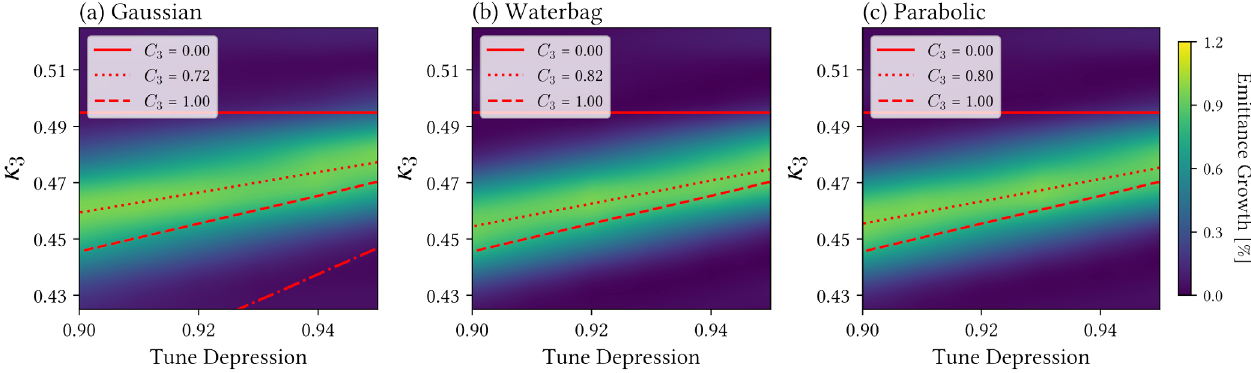
FIG. 16. Emittance growth chart of the sum resonance with ð k; l Þ ¼ ð 2 ; 1 Þ excited by the sextupole driving perturbation. The perturbation amplitude is set at 0.4% of the focusing field ’ s in these W ARP simulations. The dotted line is the location of the stop-band peak fitted by Eq. (15) with C 3 ¼ 0 . 72 for Gaussian, C 3 ¼ 0 . 82 for waterbag, and C 3 ¼ 0 . 80 for Fig. 16. Since the third-order effect is weaker than the second order ’ s, the perturbation amplitude relative to the linear focusing amplitude has been increased from 0.1% in Fig. 15 to 0.4% here. The fitting procedure based on the resonance formula in Eq. (15) with k ¼ 2 and l ¼ 1 leads to C 3 ¼ 0 . 72 (cid:3) 0 . 08 for the Gaussian distribution, C ¼ 0 . 82 (cid:3) 0 . 03 for the waterbag distribution, and 3 C ¼ 0 . 80 (cid:3) 0 . 05 for the parabolic distribution. 3